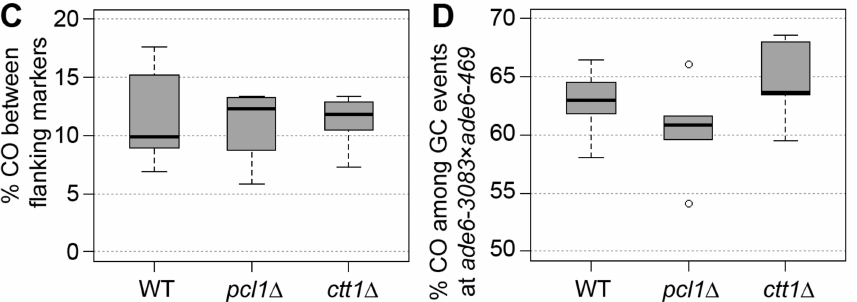
Figure 1. Spore viability and meiotic recombination outcome in wild type (WT), pcl1 ∆ , and ctt1 ∆ . ( A ) Spore viability of wild type (ALP733 × ALP731, n = 6), pcl1 ∆ (UoA1040 × UoA1043, n =